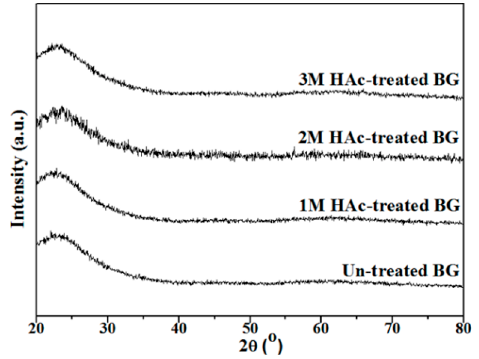
Figure 1. XRD patterns of un-treated and HAc-treated BG powders.